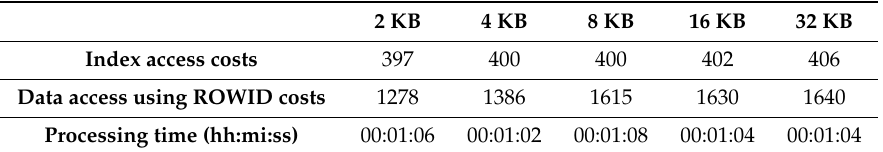
Table 6. Restricted memory structure size and performance